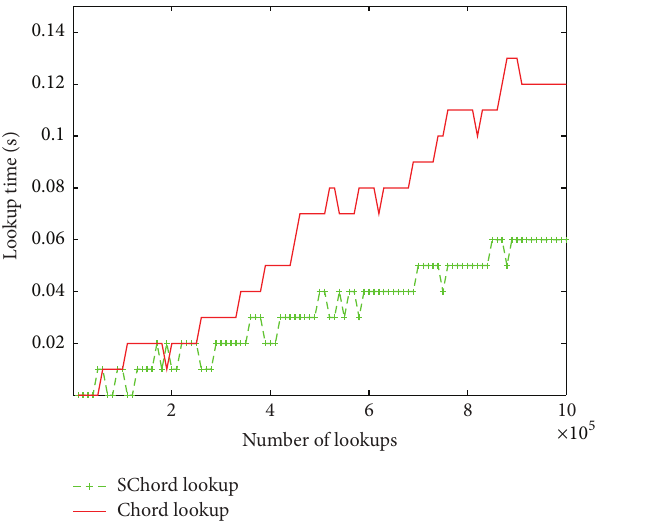
Figure 9: Hop reducing.